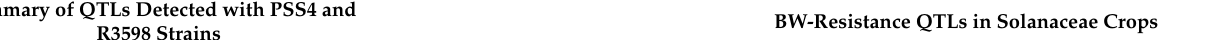
Table 5. Bacterial Wilt-resistance QTLs detected in the DH population EG203 × MM738 for which a correspondence with published Solanaceae BW-resistance QTLs was